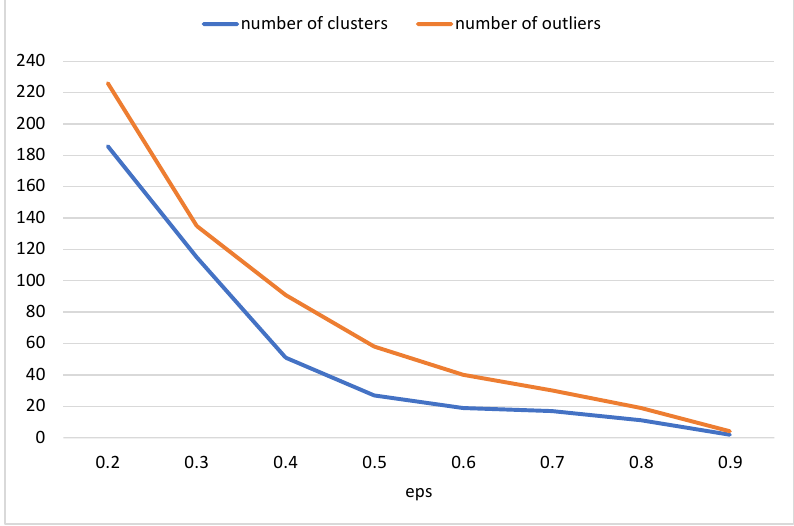
Figure 3. Effect of varying the eps parameter on the number of clusters and outliers. Table 5. Number of clusters and outliers for different eps